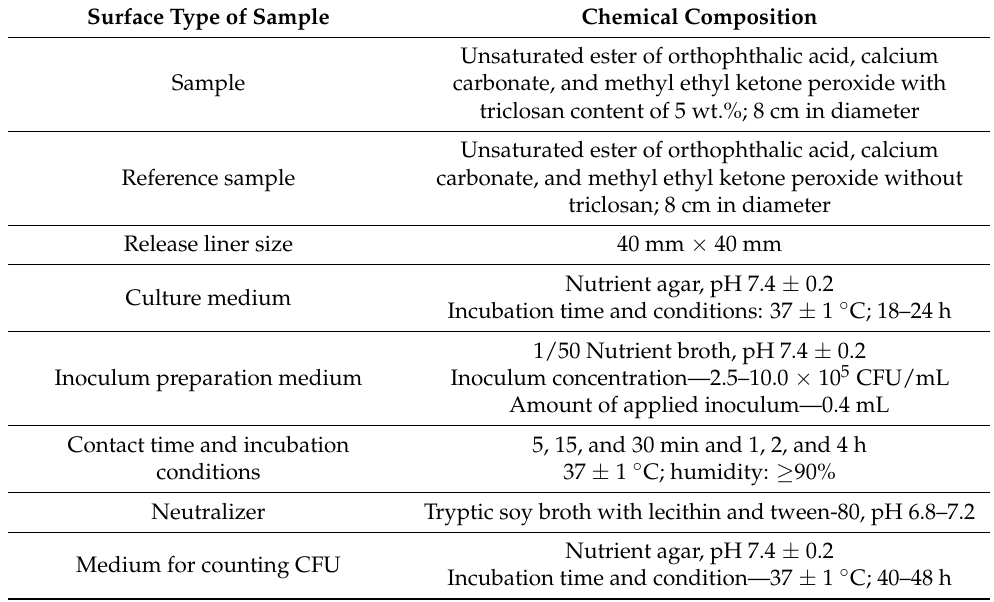
Figure 2. Inoculated experimental (with 5 wt.% triclosan) and control (without triclosan) composite samples covered with the release liner. Table 3. The incubation parameters used for antimicrobial studies.